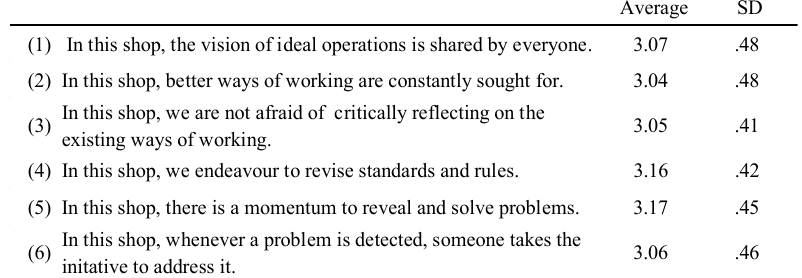
Table 1. Overview of kaizen readiness items N =54